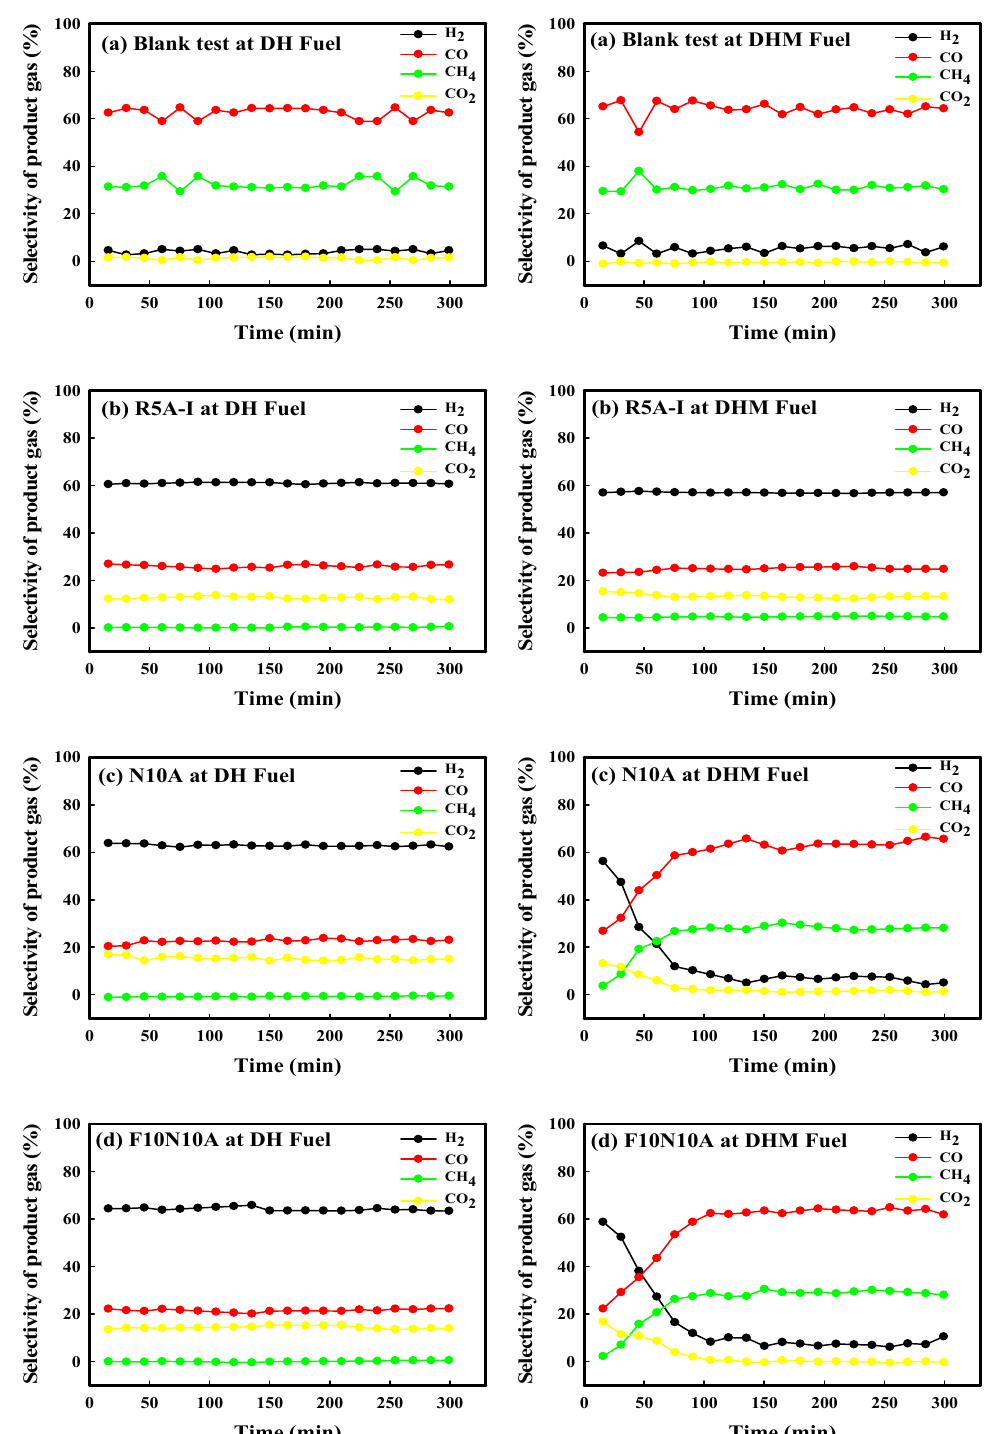
Figure 2. The selectivity of product gas (%) of the ( a ) blank test, ( b ) R5A-I, ( c ) N10A, and ( d ) F10N10A at DH and DHM fuel.